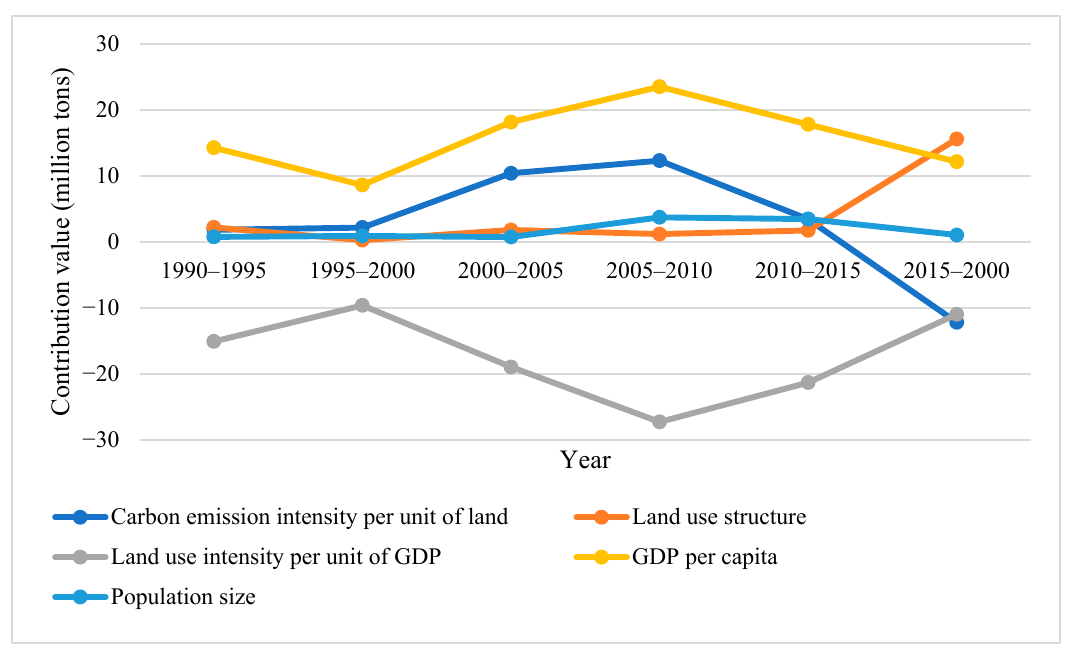
Figure 4. Contribution value of the influencing factors to variation of carbon emissions from land use change in the Beijing-Tianjin-Hebei region.